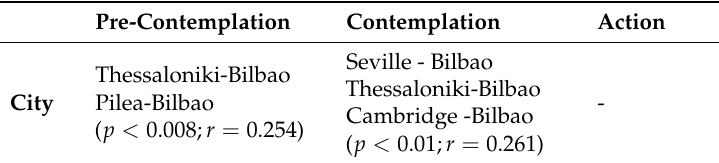
Table 9. POST-pilot: Post hoc analysis to identify where the differences are in the effect that we observed after running Kruskal Wallis test. In Pre-contemplation and Contemplation it seems that Bilbao scored differently than Greek pilots. Specificly, people in Greece scored higher on Pre-contemplation stage than the Spanish pilots. Interestingly, DEUSTO, SEVILLE and ALLIA reported the lowest scores in this stage of no-awareness. Regarding the Contemplation stage, there is a difference between the Spanish cities where DEUSTO again reported the highest average score in this stage of change and SEVILLE the lowest along with ALLIA and